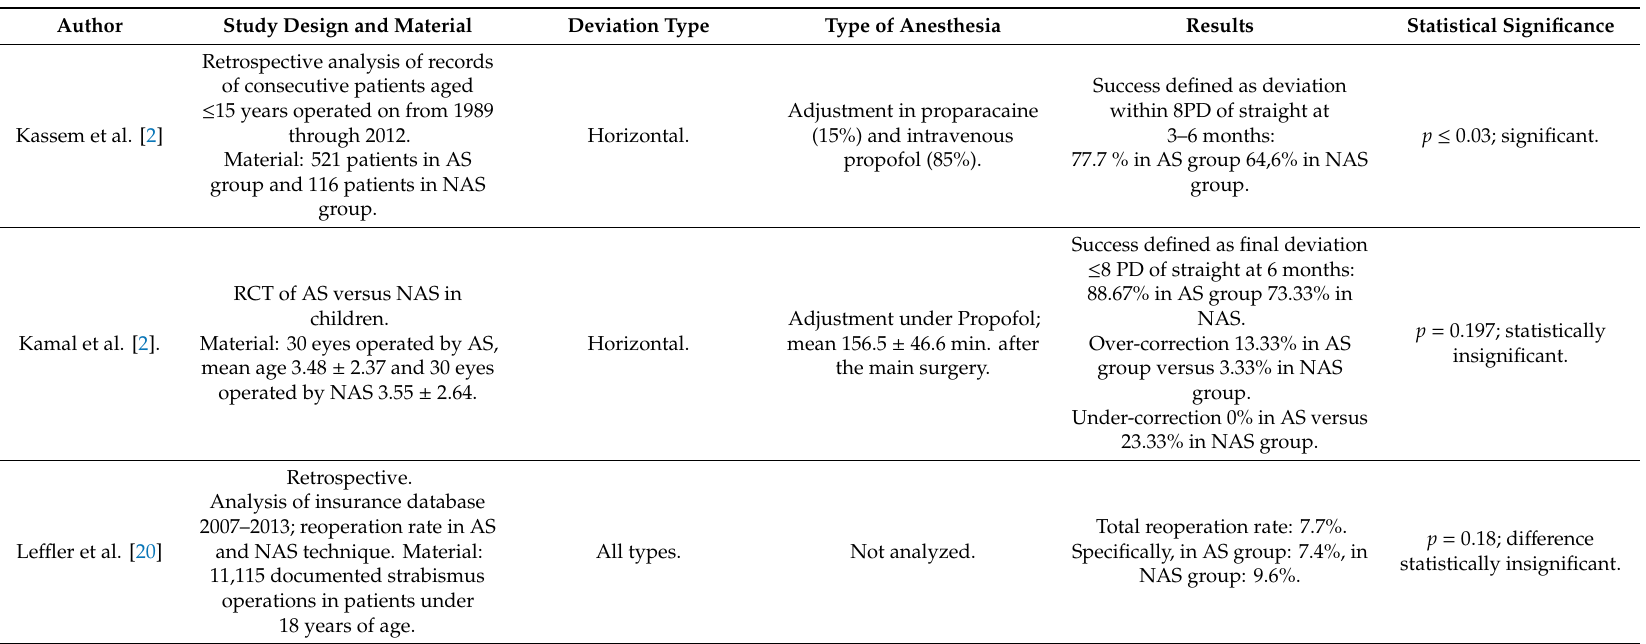
Table 2. AS versus NAS in